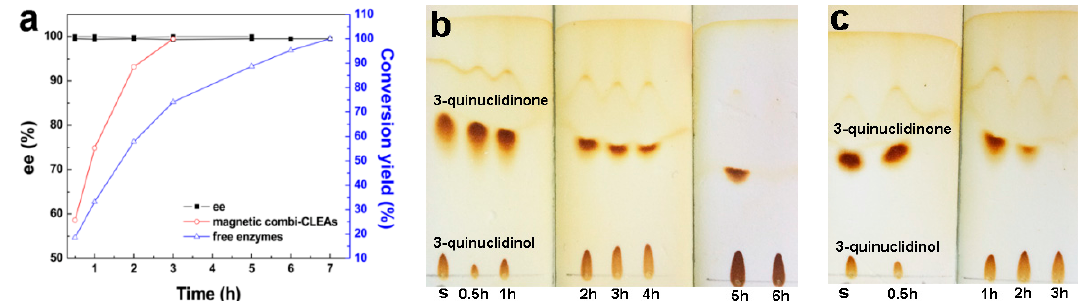
Figure 8. Reaction time-course for the bioreduction of 3-quinuclidinone into ( R )-3-quinuclidinol catalyzed by the free enzyme or the magnetic combi-CLEAs, respectively. Samples (0.5 mL) were withdrawn at the appropriate intervals and analyzed by GC ( a ) or by TLC ( b , c ).